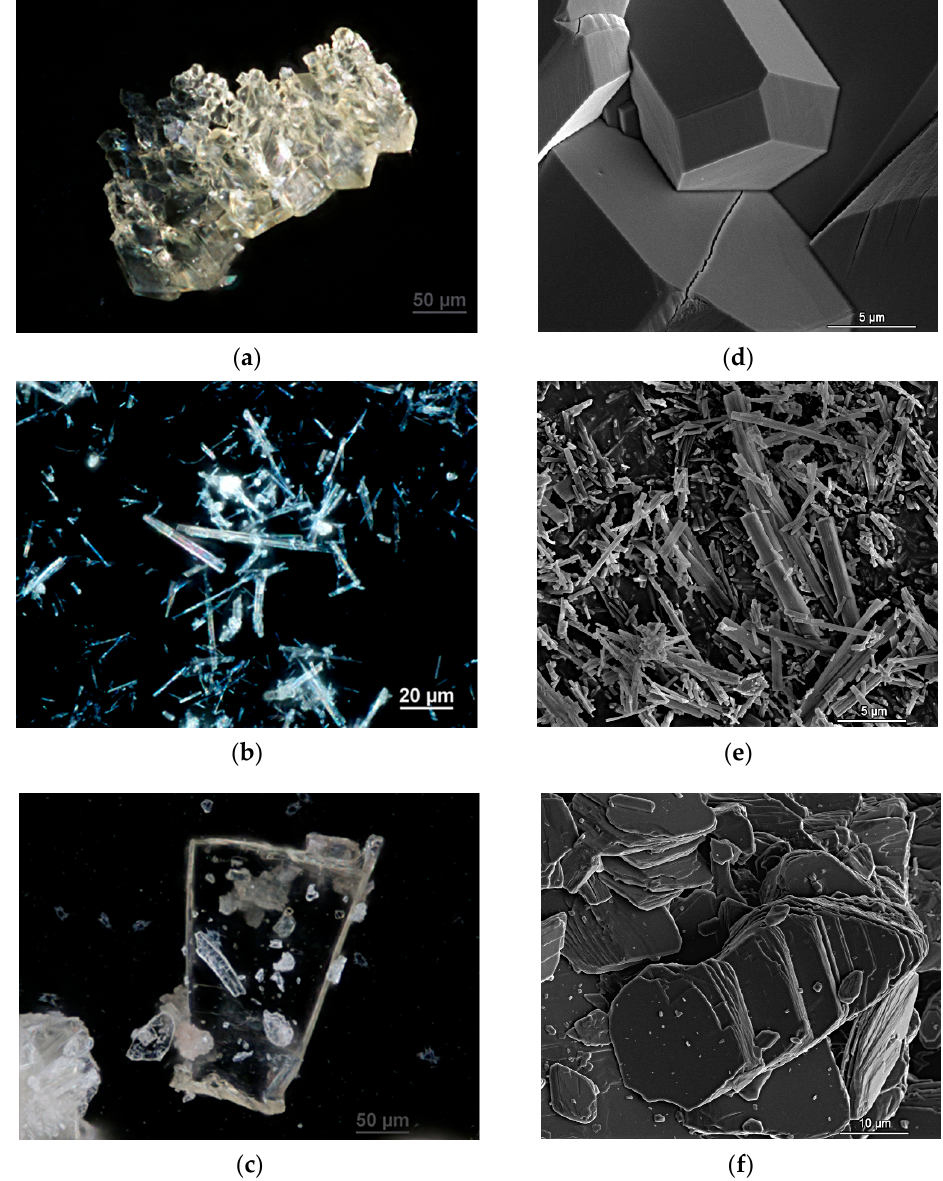
Figure 1. Images from an optical microscope ( a – c ) and SEM micrographs ( d – f ) at low voltage (5 kV) for crystalline complexes 1 ( a , d ), 2 ( b , e ), and 3 ( c , f ), respectively.